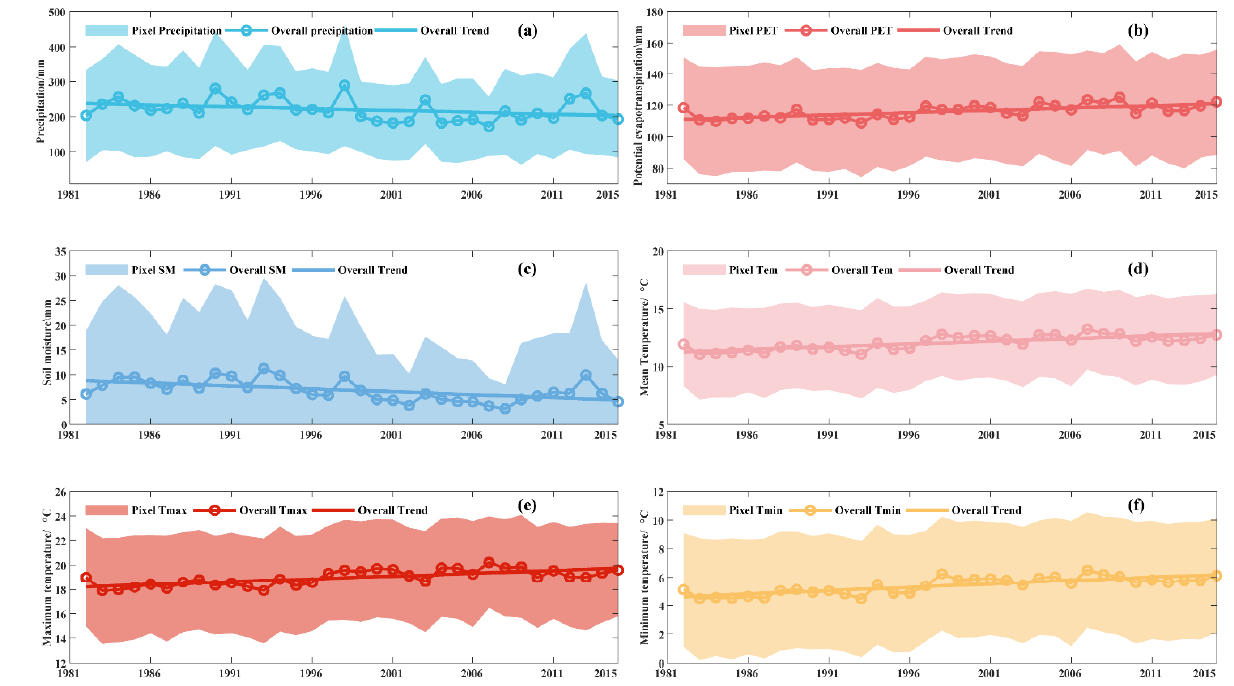
Figure 2. Long-term changes in different climatic factors during the growing season of 1982–2015 in the Mongolian Plateau. ( a ) PRE, ( b ) PET, ( c ) SM, ( d ) Tem, ( e ) Tmax, ( f ) Tmin. Coloured strips highlight sem/std, where sem is standard error of mean and SD is standard deviation of climatic factors.